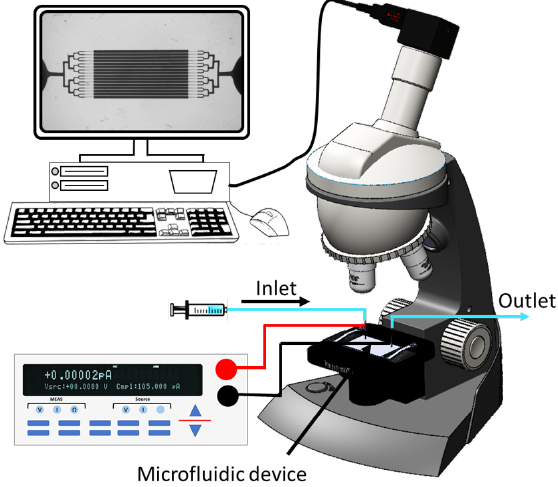
Figure 1. Sketch of our experimental setup consisting of our microfluidic device, a microscope, a camera, a sourcemeter, and a computer.